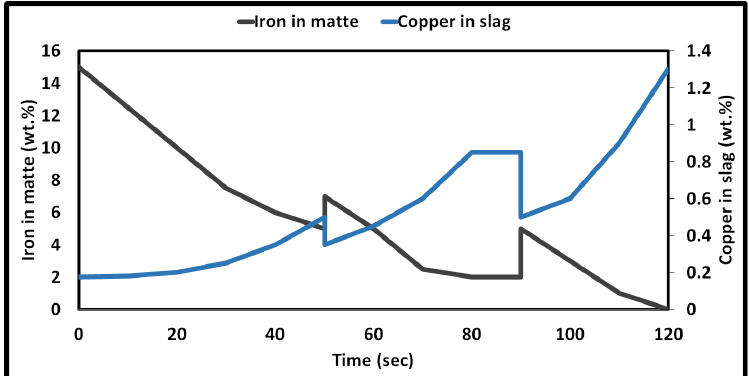
Figure 3. Iron in matte and copper in slag during slag–making